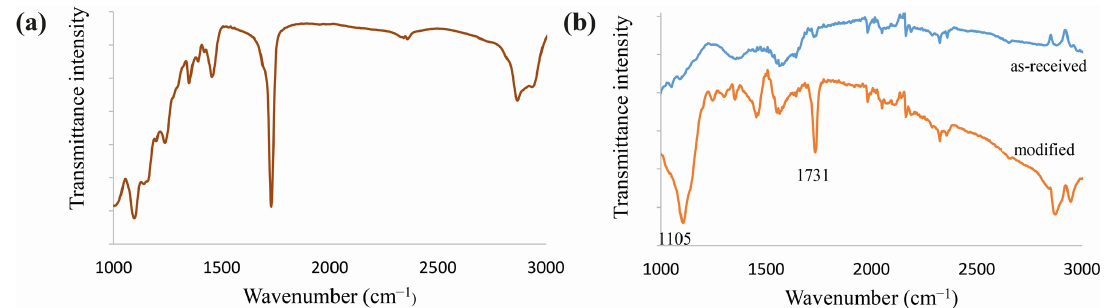
Figure 7. FTIR spectroscopy (a) Disperbyk-111. (b) As received and modified (with Disperbyk-111) 3Y-TZP